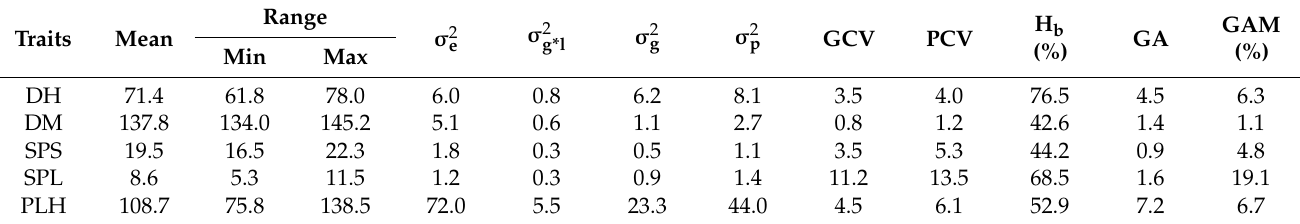
Table 1. Descriptive statistics (minimum, maximum and mean values) for 11 phenotypic traits investigated over combined locations and their corresponding estimates of genotypic variance ( σ 2 g